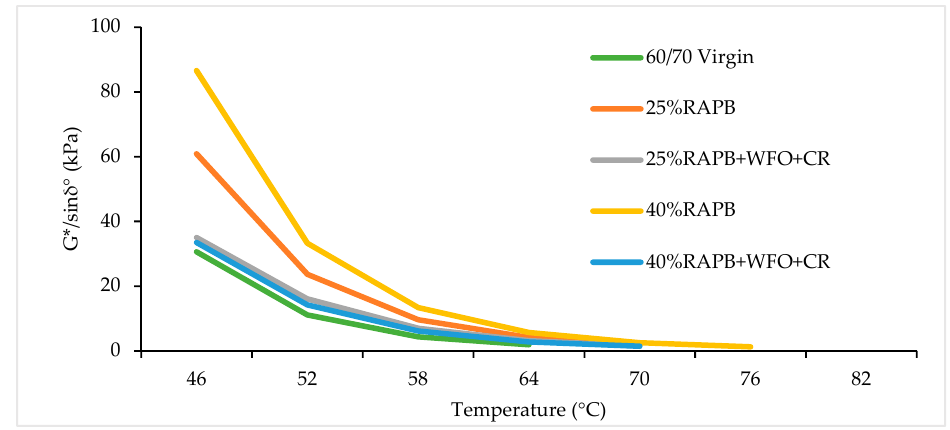
Figure 14. Rutting parameter result of virgin, virgin, RAP, and recycled binders. The failure or critical temperature is represented as the temperature obtained for the ratio of the G */sin δ parameter, which is more than 1.0 kPa for the unaged status according to the Superpave requirements [56]. The failure temperature increased by 6 and 12 ◦ C when 25% RAP and 40% RAP were added, respectively, compared to the control sample.